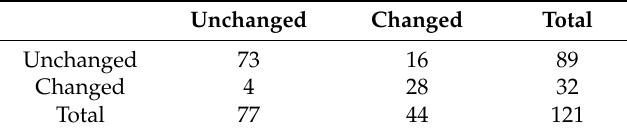
Table 10. Confusion matrix of SCCD.